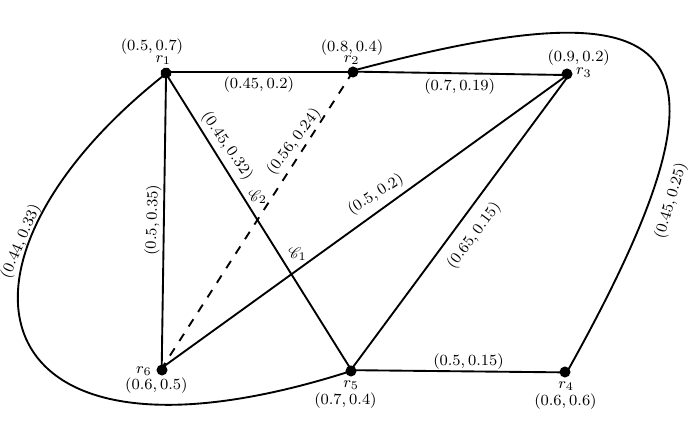
Figure 7. PFPG with two Figure 3.4: PFPG with two crossing